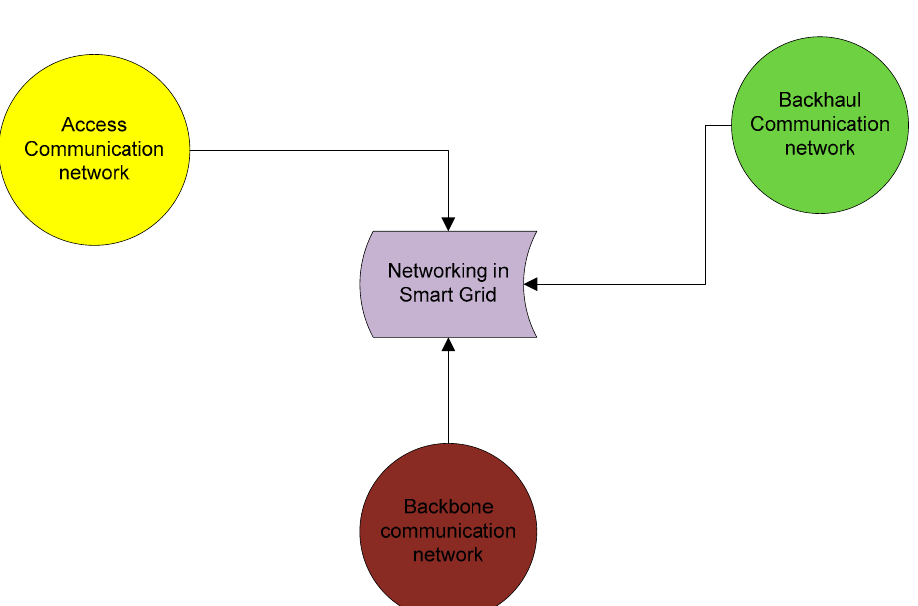
Figure 4. Network domains establishment for smart grid communication.